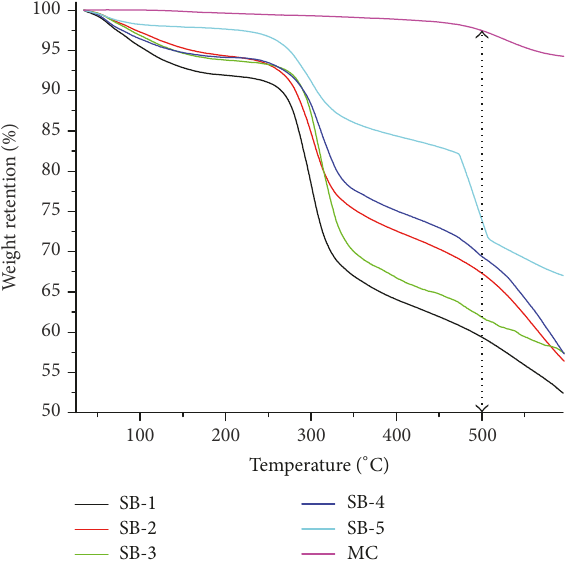
Figure 6: TGA curves of composites.